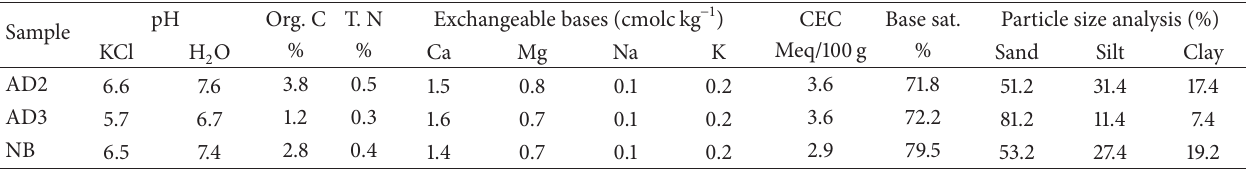
Table 2: Physicochemical properties of the soil